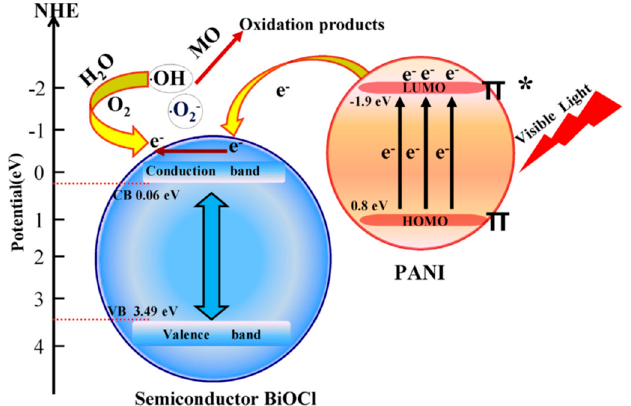
Figure 3. Schematic illustration of the proposed photocatalytic mechanism of PANI/BiOCl under visible light irradiation [21].